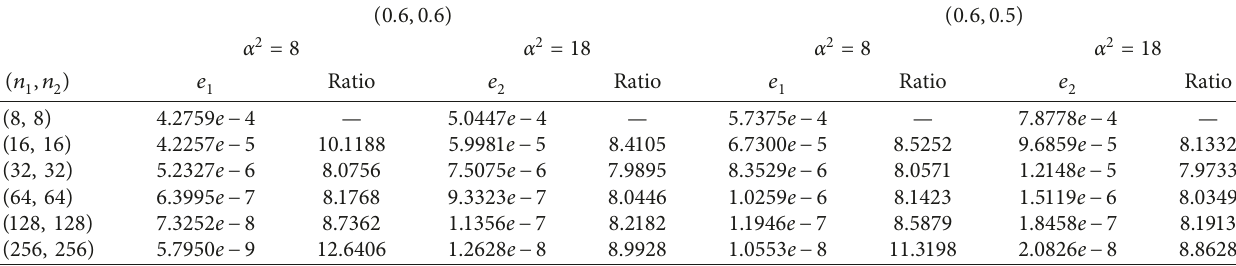
Table 3: The simulation results for Example 2.